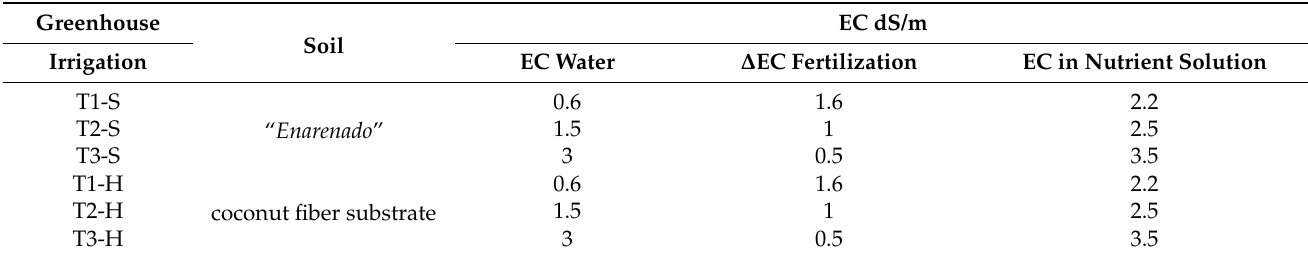
Table 1. Electric conductivity in different irrigation areas in the experiment. T, treatment; S, typical soil substrate “enarenado”; H, coconut fiber